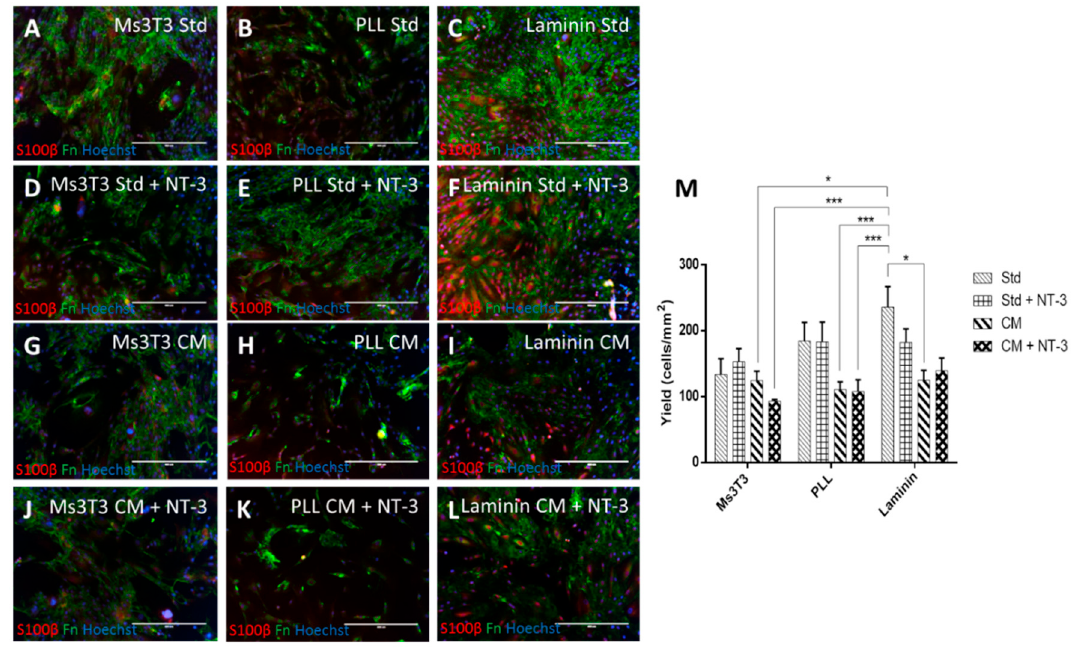
Figure 4. PA5 cells cultured on laminin or Ms3T3 feeders, in standard media or HuG418 conditioned media. Cells were cultured for five days and stained for S100 β and Fn ( A–L ). S100 β -positive cells were quantified in ImageJ and graphed as yield of positive cells in the image area ( M ). Conditioned media constantly gave lower yields of S100 β , and laminin with standard media gave the highest yield. The scale bars represent 400 μ m. Data are the means ± SEM, n = 3.